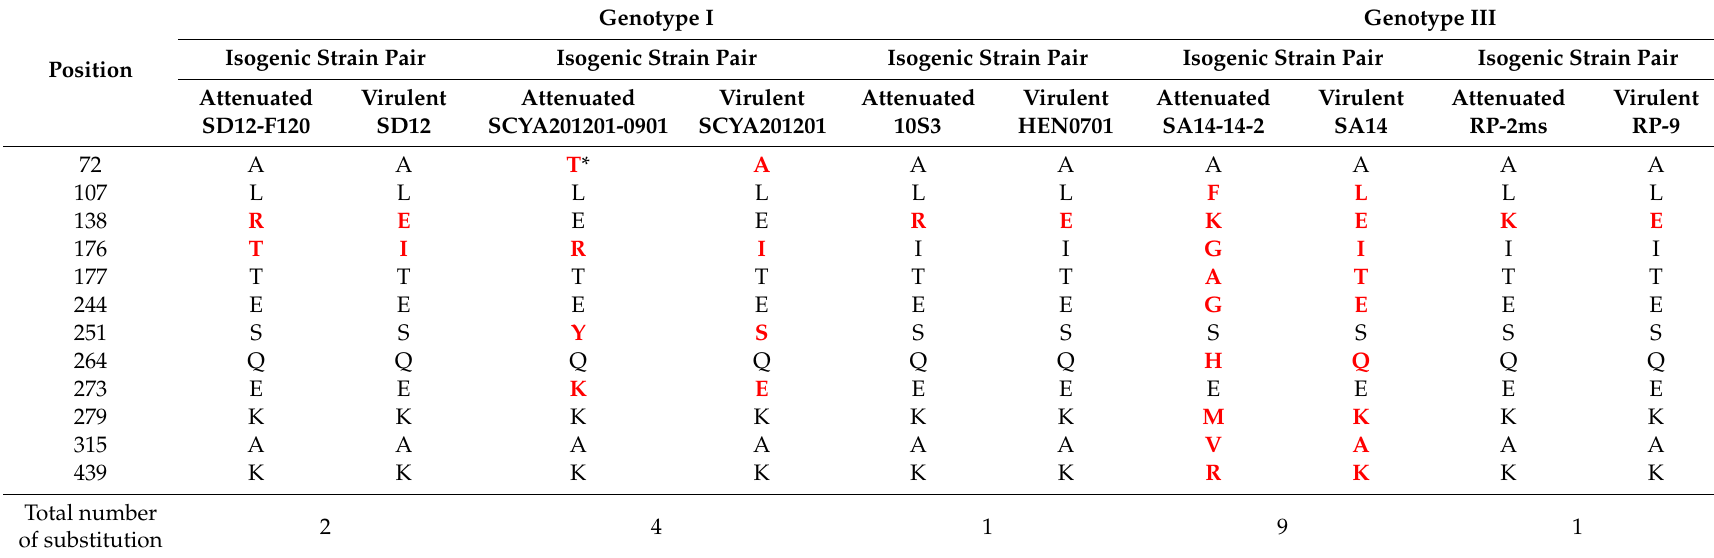
Table 2. Amino acid substitutions in E protein between attenuated and virulent parental